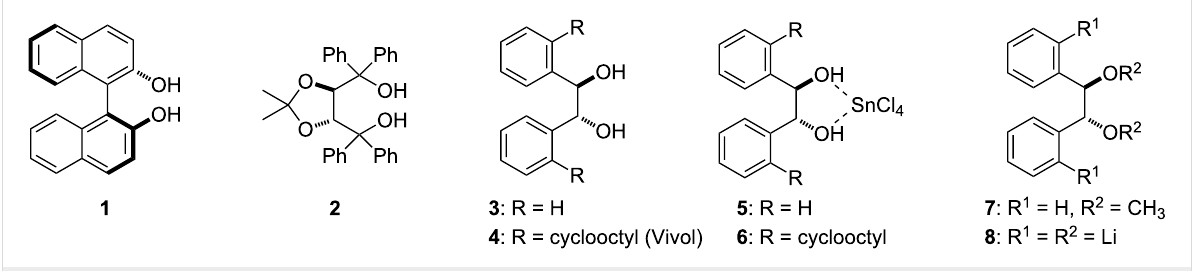
Figure 1: Chiral diols useful for asymmetric synthesis and the tetralithio intermediate 8